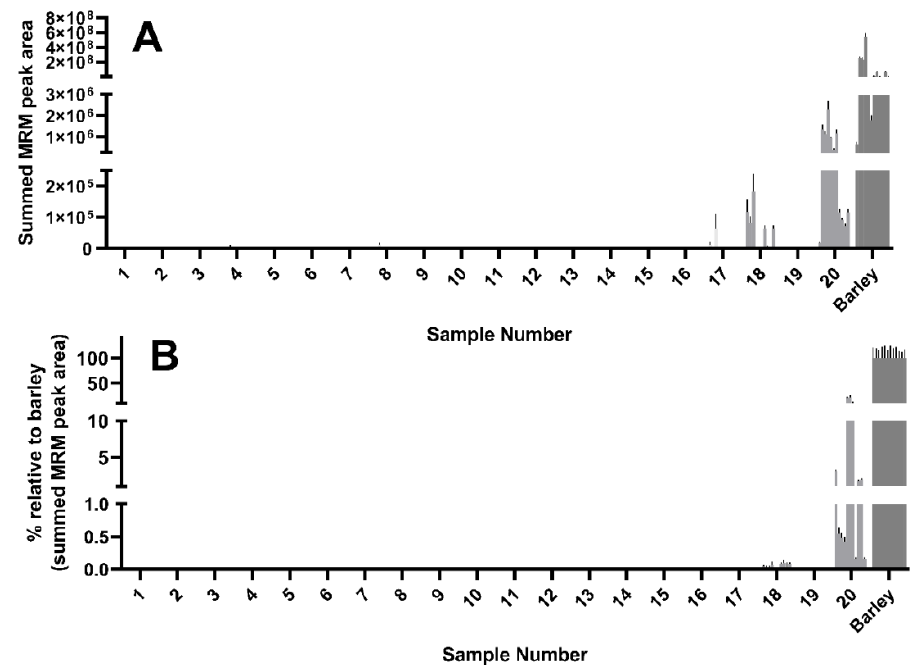
Figure 7. Detection of barley marker peptides by LC–MS. Significant levels of barley were detected in samples 17, 18 and 20, with trace levels detected in samples 8 and 14. ( A ) LC–MS peak area of 9 barley peptide markers (raw data). ( B ) Peak area normalized to barley expressed as a percentage. Barley gluten was estimated in yeast samples using the same approach as described above for wheat. A combination of barley-free yeast extracts (samples 3, 5, 7, and 10) was generated into which barley was spiked at a known concentration in order to negate any matrix e ff ects and enable a standard curve to be generated with which barley gluten content could be estimated (Figure 8A). The barley gluten content was estimated as shown in Figure 8C using this standard curve and the peak areas displayed in Figure 7A. This approach estimates that the barley gluten detected in samples 8 and 17 were likely to be below the 20 mg / kg regulatory threshold defined by the Codex Alimentarius, while barley gluten in samples 18 (~41 mg / kg barley) and 20 (~772 mg / kg barley) is estimated to be significantly higher than 20 mg /